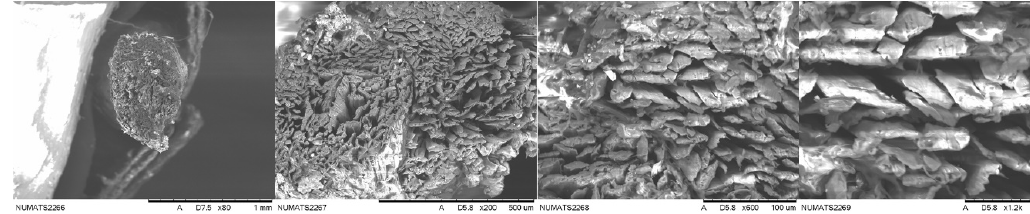
Figure 7. SEM images of an impregnated yarn in different magnification scales: 80X, 200X, 600X, 1200X.